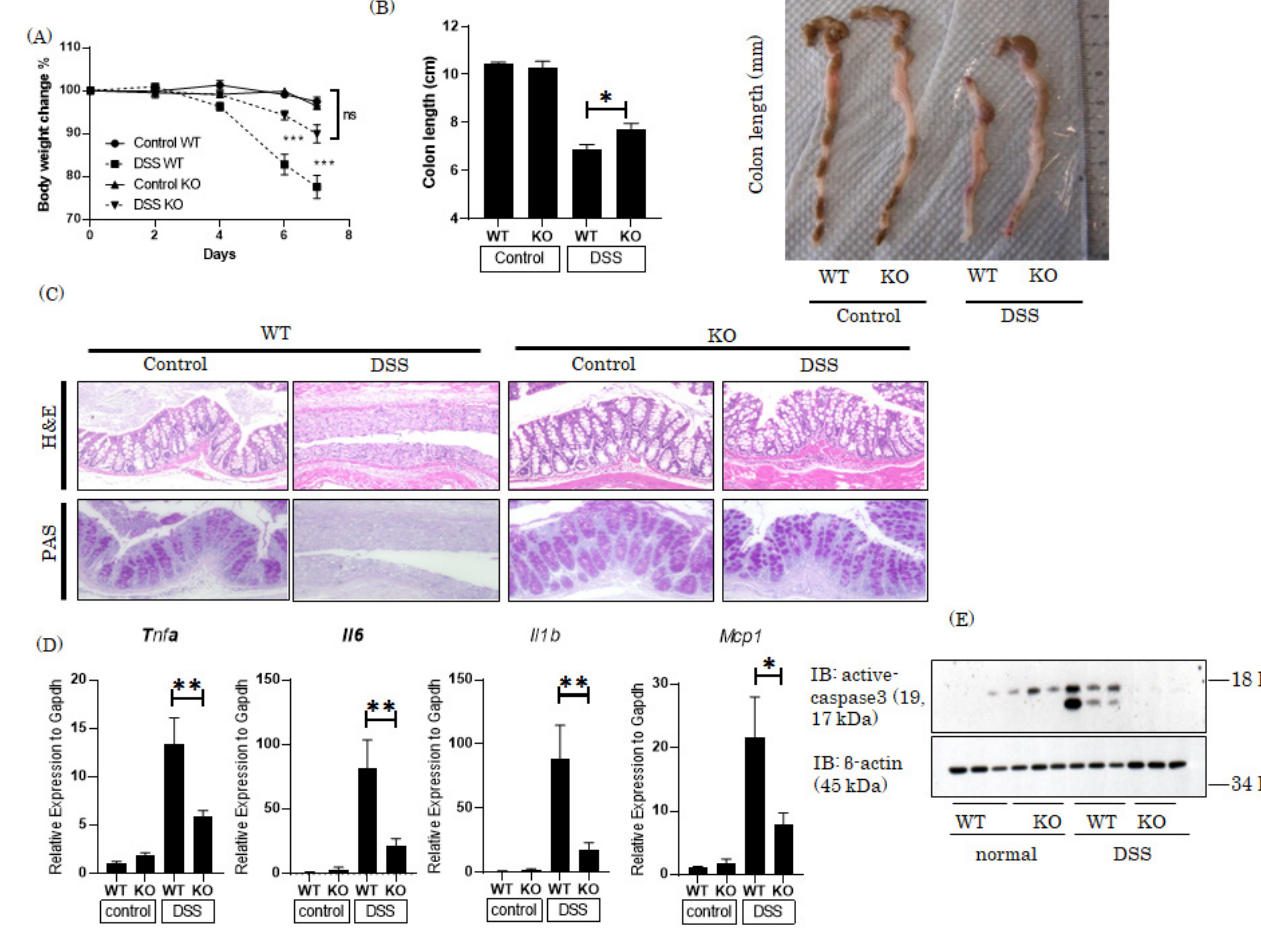
Figure 2. Global Pin1 KO mice were resistant to the development of DSS-induced colitis. Global Pin1 KO mice were generated by mating Pin1 fl/fl and CAG cre-TG mice (n = 5–8). Pin1 KO and control Pin1 fl/fl mice were treated with 3% DSS for 7 days. ( A ) Body weight, ( B ) colon length ( C ) and histology based on H&E and PAS staining of colonic sections ( D ) The mRNA levels of Tnf α , Il6 , Il1b and Mcp1 were measured by RT-PCR. ( E ) Active forms of caspase 3 and α -tubulin in the colons were detected by immunoblotting. Significant differences were identified by applying a one-way ANOVA fol- lowed by Tukey’s multiple comparisons test. ns, not significant, * p < 0.05, ** p < 0.01, *** p < 0.001 Values are means ± SEM.